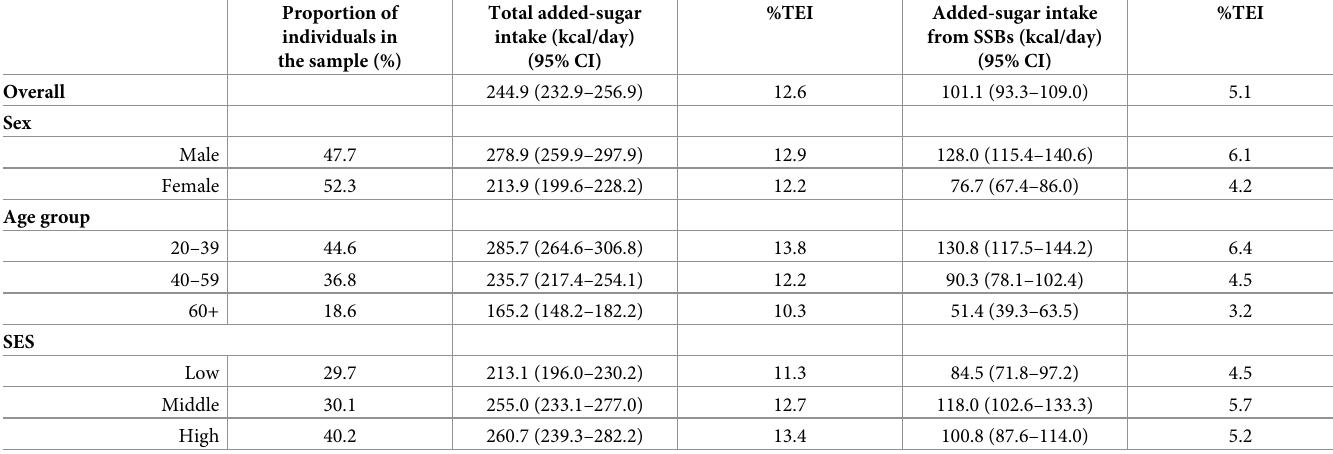
Table 1. Sample characteristics, added-sugar intake (total and from SSBs) in and their contribution to the %TEI for the adult population in Mexico before regulation. Proportion of individuals